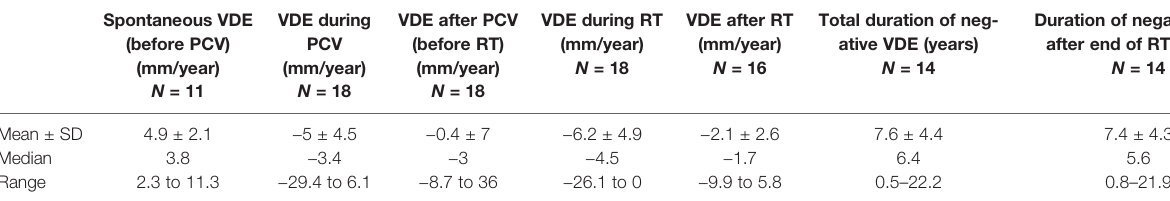
TABLE 3 | Tumor kinetics before, during, and after the combined therapy. Spontaneous VDE (before